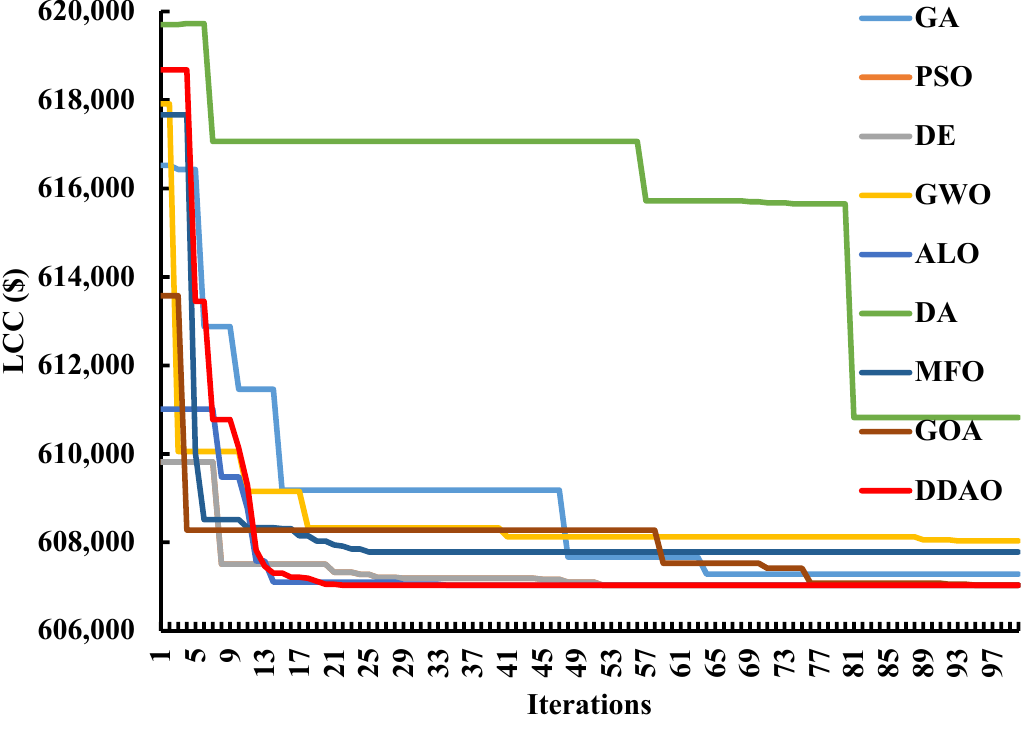
Figure 10. Convergence curves of the configuration made up of LA battery.